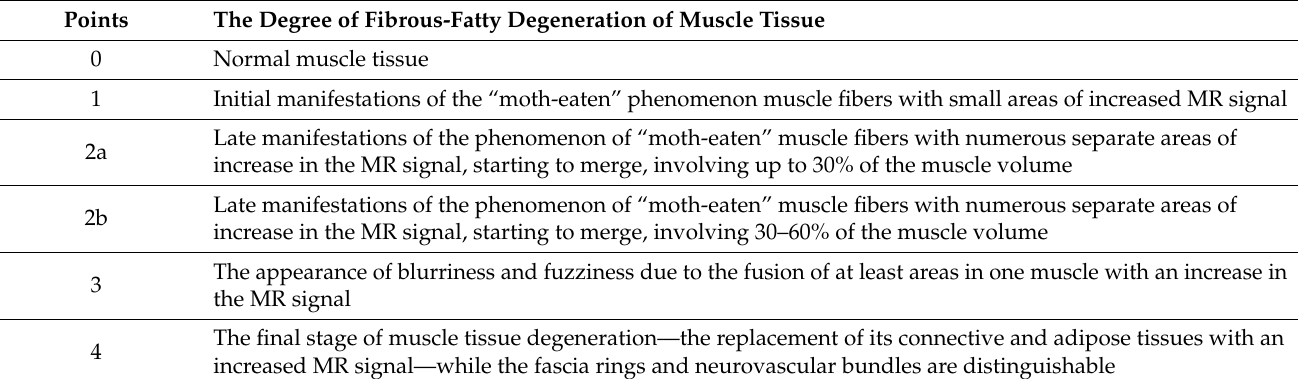
Table 1. Mercuri Fibroid Fat Degeneration Scale.